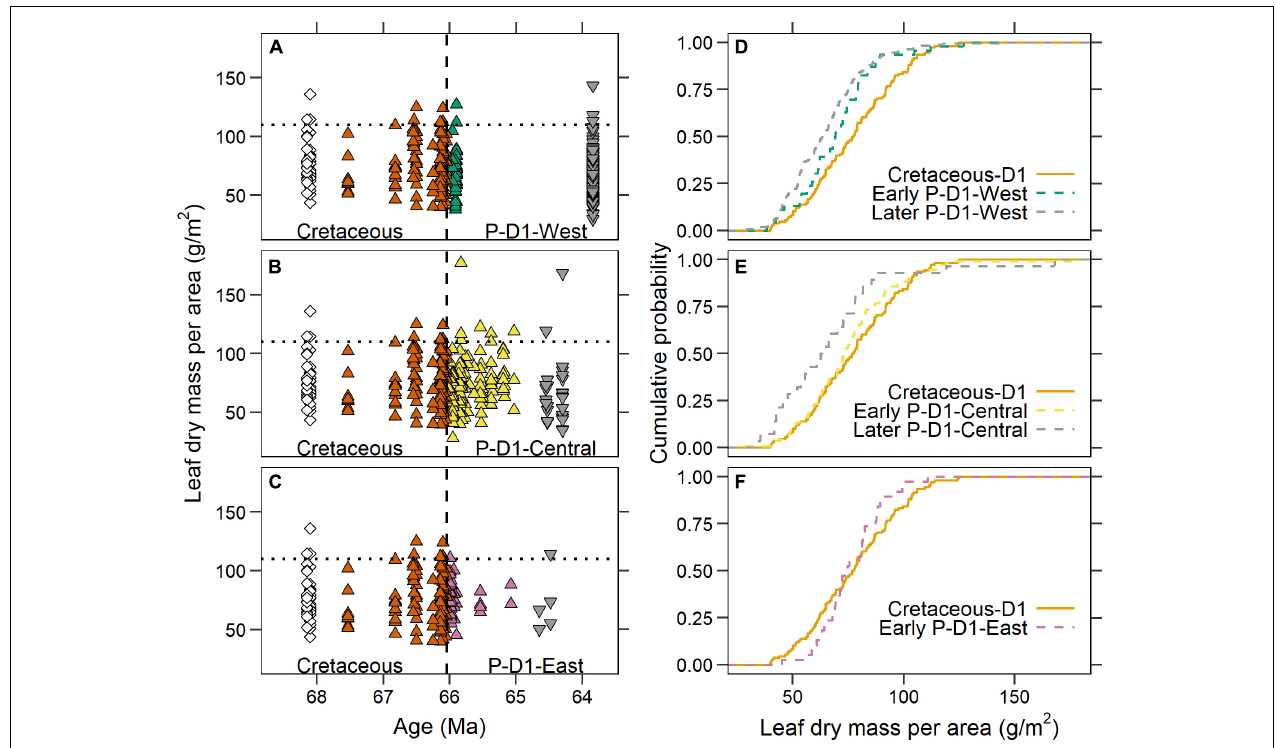
FIGURE 6 | Leaf dry mass per area (LMA) of the three Paleocene D1 megafloral associations. (A–C) Comparisons of LMA in the Denver Basin between the Cretaceous and (A) P-D1-West; (B) P-D1-Central; and (C) P-D1-East associations. The Cretaceous species-site pairs are identical to Figure 5A and are identical in all three panels. In the Paleocene, upward facing triangles = early Paleocene D1 (66.04–65 Ma); downward facing triangles = later Paleocene D1 ( < 65 Ma). The sum of Paleocene data across all three panels is identical to Figure 5A . (D–F) Cumulative distribution functions of LMA from different temporal groupings in the Denver Basin in (D) P-D1-West; (E) P-D1-Central; and (F)